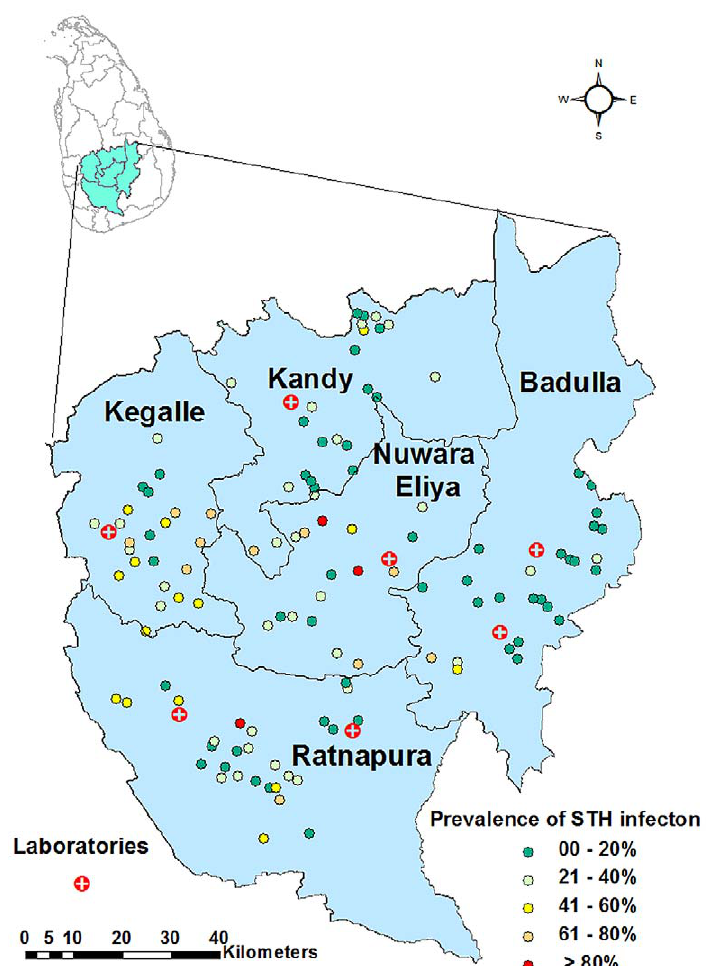
Figure 1. Geographical location of study schools and laboratories in the districts of Kandy, Kegalle, Nuwara Eliya, Badulla and Ratnapura, together with prevalence of infection with any one or more soil-transmitted helminth infection at each school.